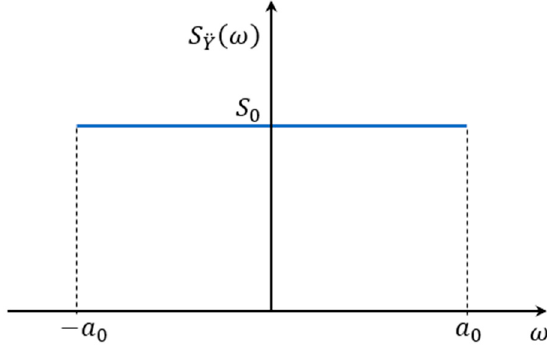
Figure 8. Spectral density of the base acceleration.